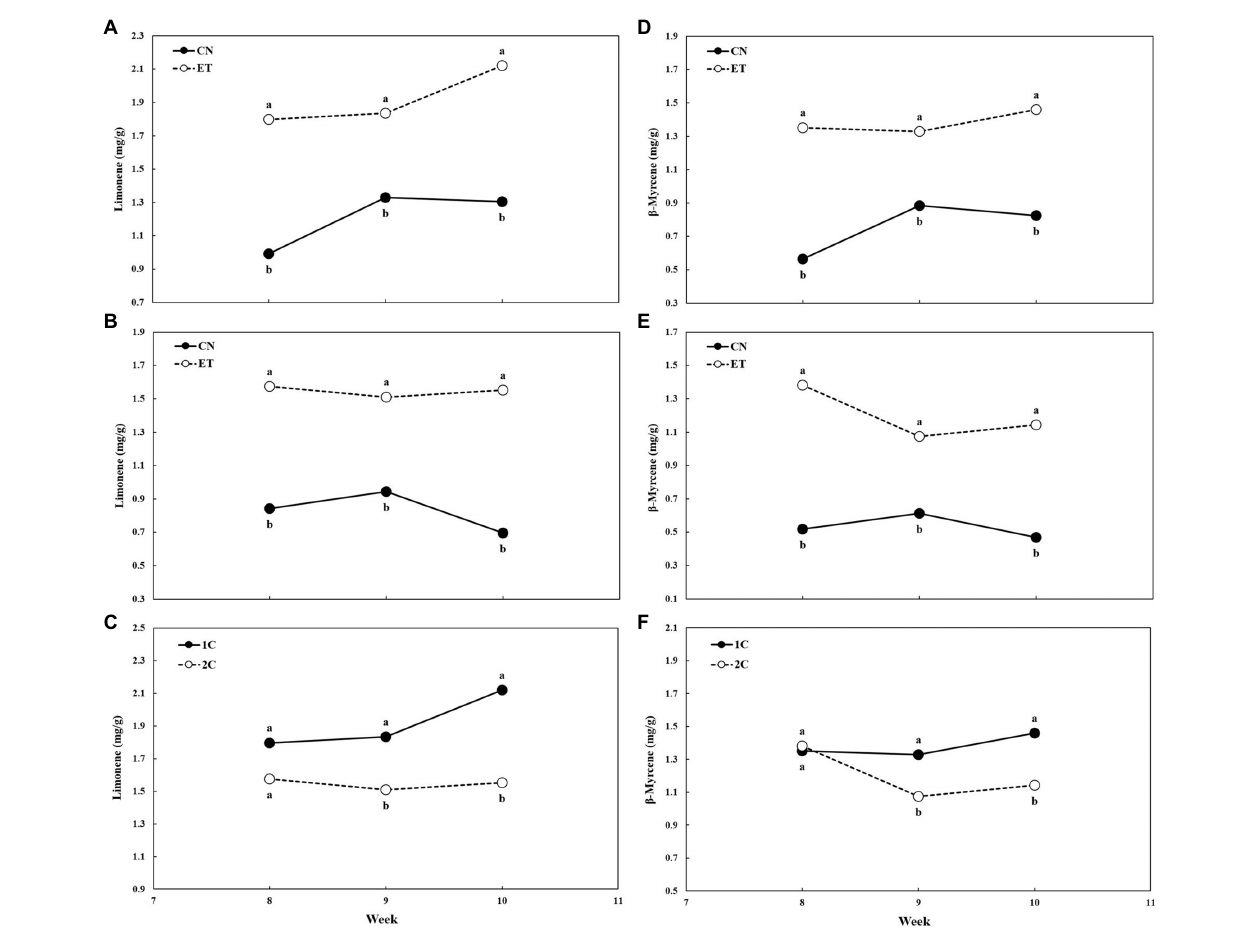
FIGURE 9 | Concentration of limonene and β -myrcene in flowers of medical cannabis plants as affected by amino acid (AA) supplementation and nutrient cycle. Limonene concentration in control (CN) and enhanced treatment (ET) plants with AAs nutritional supplements in recirculation (1C) nutrient cycle (A) , in drain-to- waste (2C) nutrient cycle (B) , ETs in 1C and 2C (C) , the β -myrcene concentration of control (CN) and enhanced treatment (ET) with AAs nutritional supplements in recirculation (1C) growing cycle (D) , in drain-to-waste (2C) growing cycle (E) , ETs in 1C and 2C (F) . The whole inflorescence of the plant was analyzed. Data are means ± SE ( n = 3). Different bold small letters represent significant differences in cannabinoid concentration between the variants in a particular week according to Tukey’s HSD test at α =